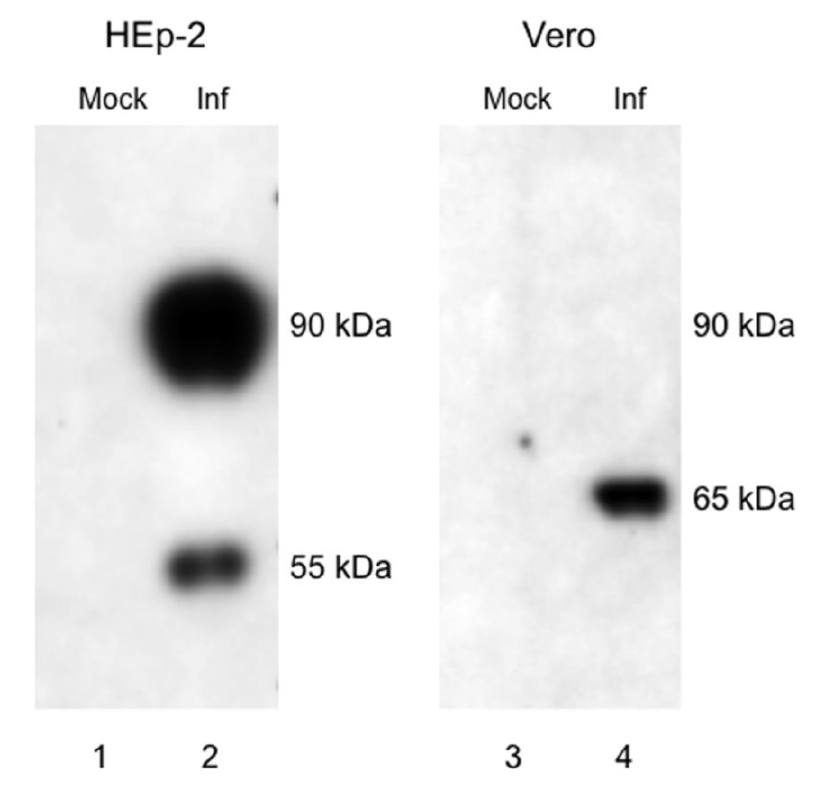
Figure 1. G glycoprotein expression RSV Memphis 37-infected Vero cells compared to infected HEp-2 cells. M37 RSV virus was grown for 2 passages in HEp-2 or Vero cells. Equivalent concentrations of whole cell lysate from mock or infected cells were then analyzed by western blot for expression of the RSV G protein. The majority of the G protein produced by RSV grown in HEp-2 cells was the 90 kDa form, with a minor band representing the 55 kDa form. In contrast, RSV grown in Vero cells produced undetectable levels of the 90 kDa form of the G protein, and instead produced a truncated 65 kDa form. Results are representative of three independent